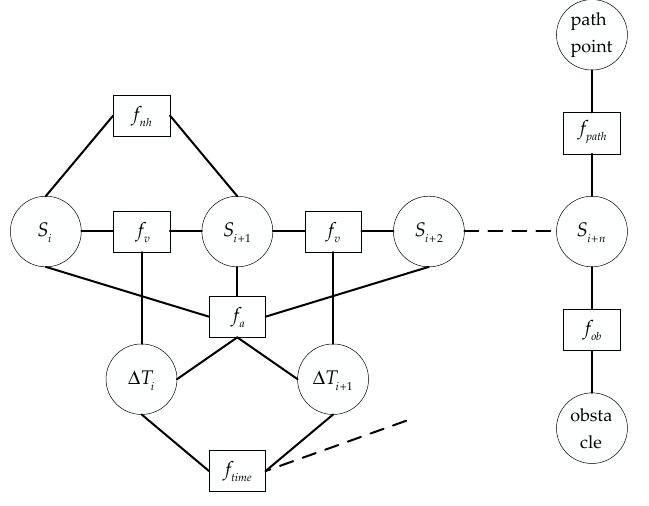
Figure 2. TEB hyper-graph structure.